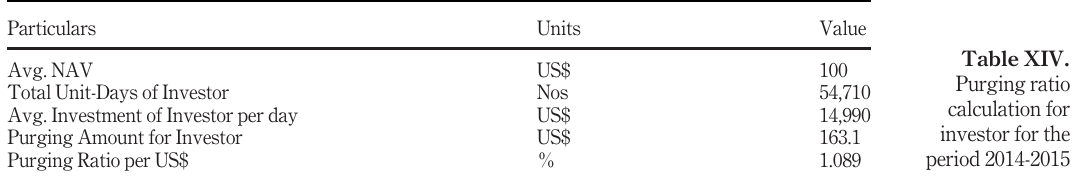
calculation for investor for